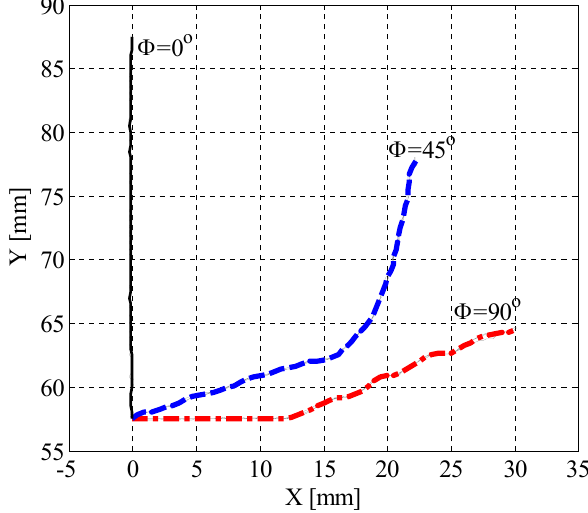
Figure 4b. Mean displacement trajectories in the X-Y-frame of an object (Dobj=115 mm) while it was pulled in three different directions Φ (see also Fig. 2). F is normalized to the actuation torque Ta and the finger length L. The gray, thin lines represent the raw data. Table 2. Results of benchmark test 2, showing the minimal force needed to extract an object of D obj = 115mm all the way out of the hand in three di ff erent directions (standard deviation between brack- ets). The second line shows the force normalized by the actuation torque ( T a = 557Nmm) and finger length ( L =